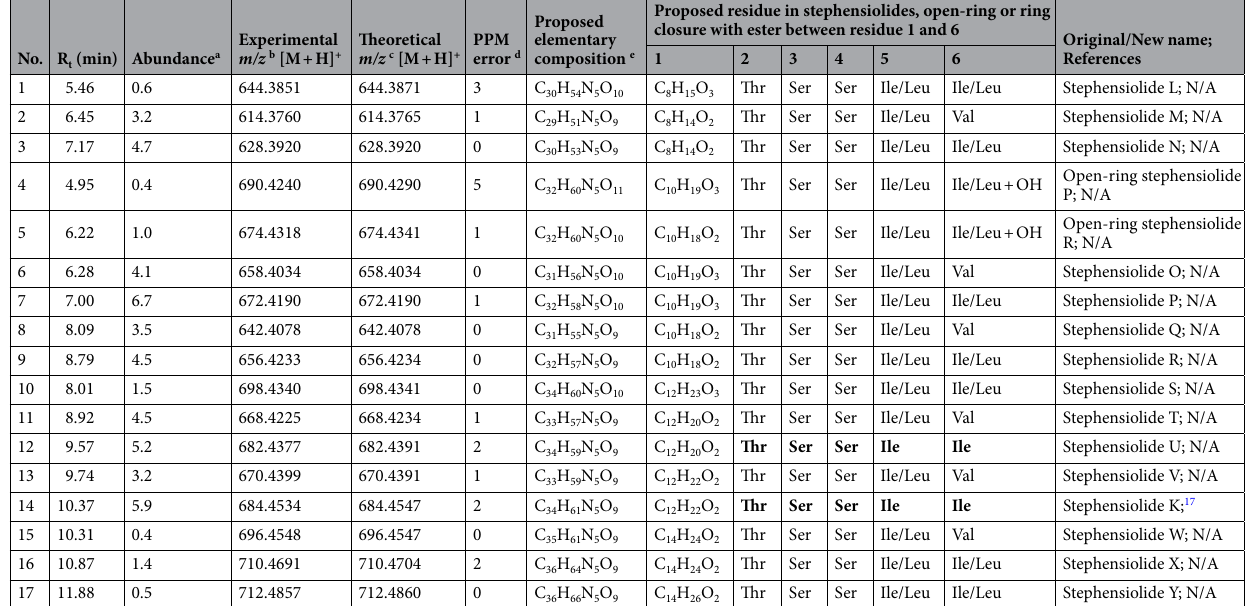
15 , respectively), corresponding to known stephensiolides, distinctive differences were observed in the expected fragmentation pattern (i.e., Ile/Leu at residue 5) (Supplementary Table S3; Supplementary Fig. S2). For example, the analysis of HRMS for compound 12 provided a [M + H] + ion at m/z 682.4377, that correlated to the molecu- lar formula C 34 H 59 N 5 O 9 (Table 1), which was analogous to StpH. However, the MS E fragmentation profile of 12 revealed major product ions at m/z 664.428, 551.345, 438.259, 351.231 and 264.197 [M + H] + (Supplementary Table S3) and an internal ion of m/z 419.25 corresponding to Ser-Ser-Ile/Leu-Ile/Leu + H, OH (Fig. 2). This putatively directed the identification of structure 12 as C 12 H 20 O 2 -Thr-Ser-Ser-Ile/Leu-Ile/Leu (Table 1) with the initial fragmentation occurring at the ester bond between residue 2 (Thr) and 6 (Ile/Leu). Moreover, 1 H NMR putatively elucidated the structure of this novel analogue as C 12 H 20 O 2 -Thr-Ser-Ser-Ile-Ile (Table 2; Fig. 3a and Supplementary Figure S1). This compound thus differed from that of the previously described StpH with an identical m/z 682.4385 [M + H] + ion and molecular formula of C 34 H 59 N 5 O 9 , with differing residues 1, 5 and 6 (Table S4) 17 . Similar distinctions were observed in the internal ions and MS E analysis for compounds 2 , 3 , 8 , 9 , 11 , 13 and 15 , indicating that these compounds are new stephensiolide analogues and were thus named accord- ingly (Fig. 2; Table 1, Supplementary Tables S3 and S4).